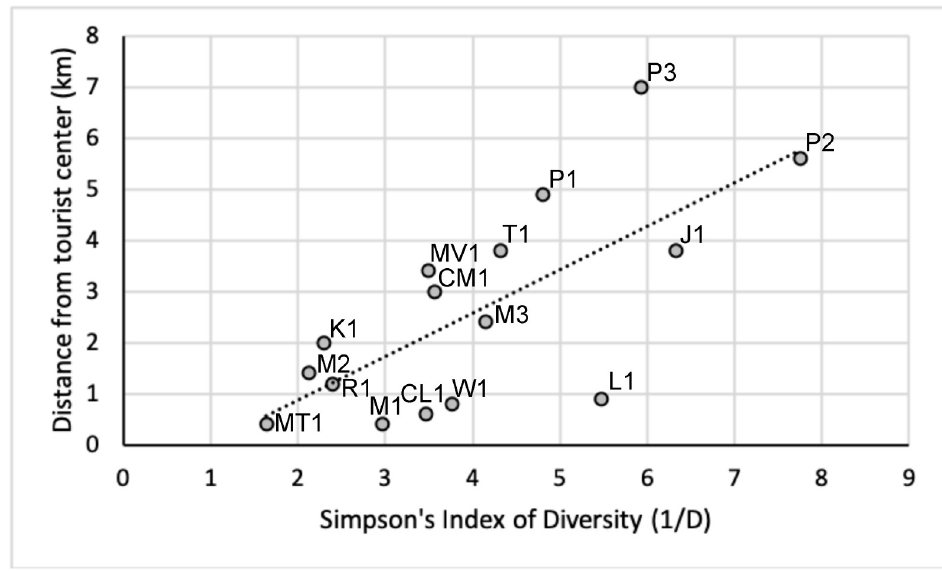
in the number of species. On the contrary, the second busiest trail, to Mazaroni Top, had the highest number of species. However, there was a significant negative correlation between the annual number of tourists and Simpson’s Diversity Index (r = -0.622, p = 0.01) (Fig 2) and a significant positive correlation between the distance to the tourist center and Simpson’s Diver- sity Index (r = 0.709, p = 0.002) (Fig 3). The Pearson correlation between the number of triggers of a mammal species and the num- ber of tourists was significantly positive for the margay, ocelot and spotted paca and signifi- cantly negative for the lowland tapir, jaguar and collared peccary (Fig 4). The correlation